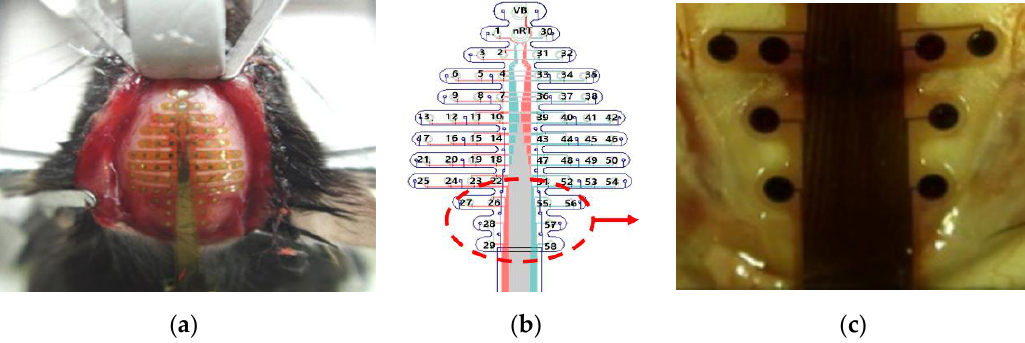
Figure 9. Images of the microelectrode: ( a ) Flexible MEAs mounted on the skull of an adult male mouse; ( b ) arrangement of the high-density mouse ECoG electrodes; and ( c ) microscopic photograph of the partially enlarged MEAs.